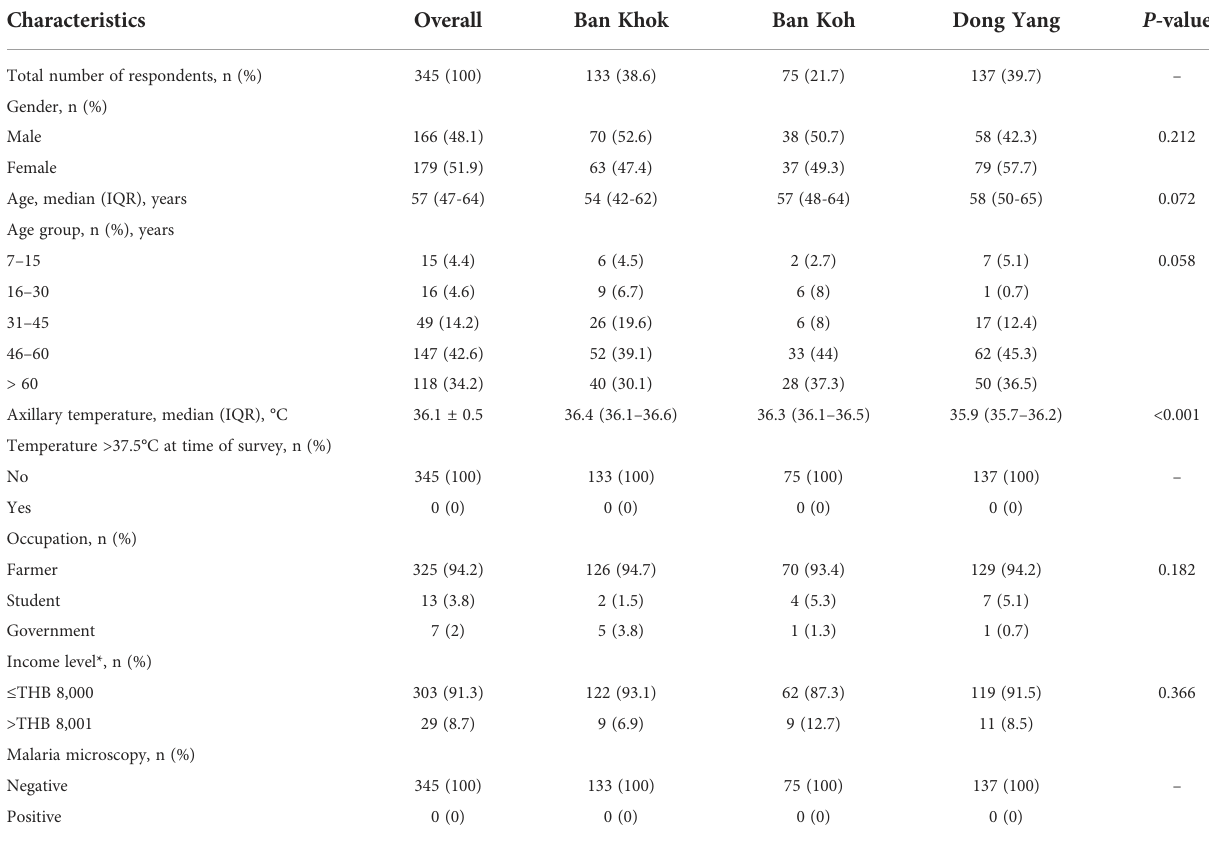
TABLE 1 Sociodemographic characteristics of respondents in three forest-goer communities in Mukdahan Province, Northeastern Thailand in 2019.